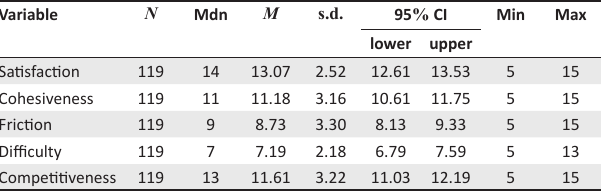
TABLE 3: Descriptive statistics for the classroom climate scales for the total sample.